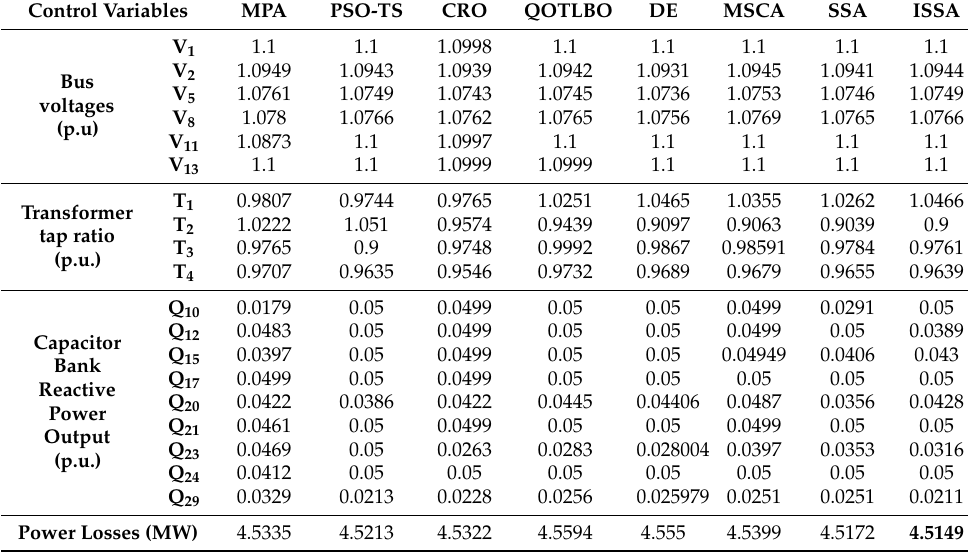
Table 9. Optimal control variables settings for power-loss minimization using different algorithms for IEEE 30-bus system.